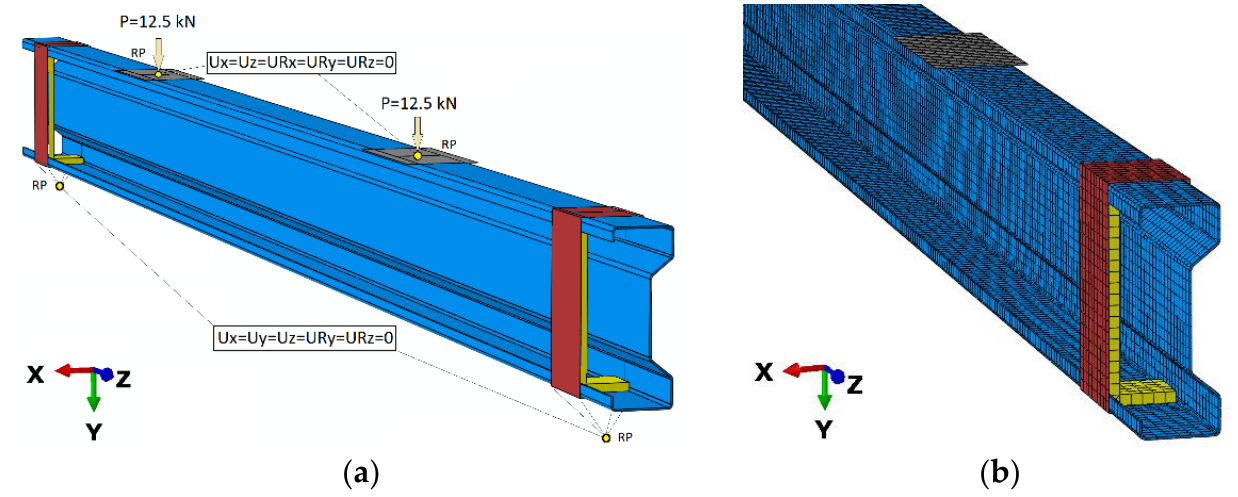
Figure 8. Numerical model: ( a ) model with boundary condition, and ( b ) discrete model.